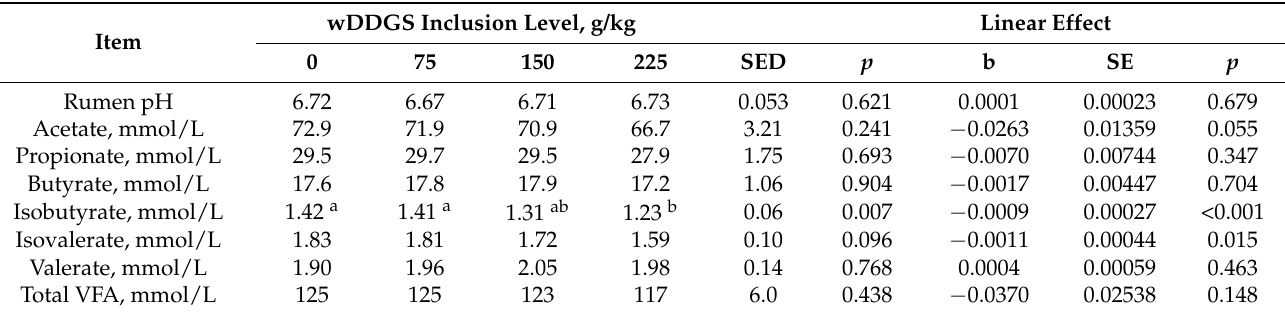
Table 7. (Experiment 2) Mean rumen pH and volatile fatty acid concentrations of cows when fed on diets containing 0